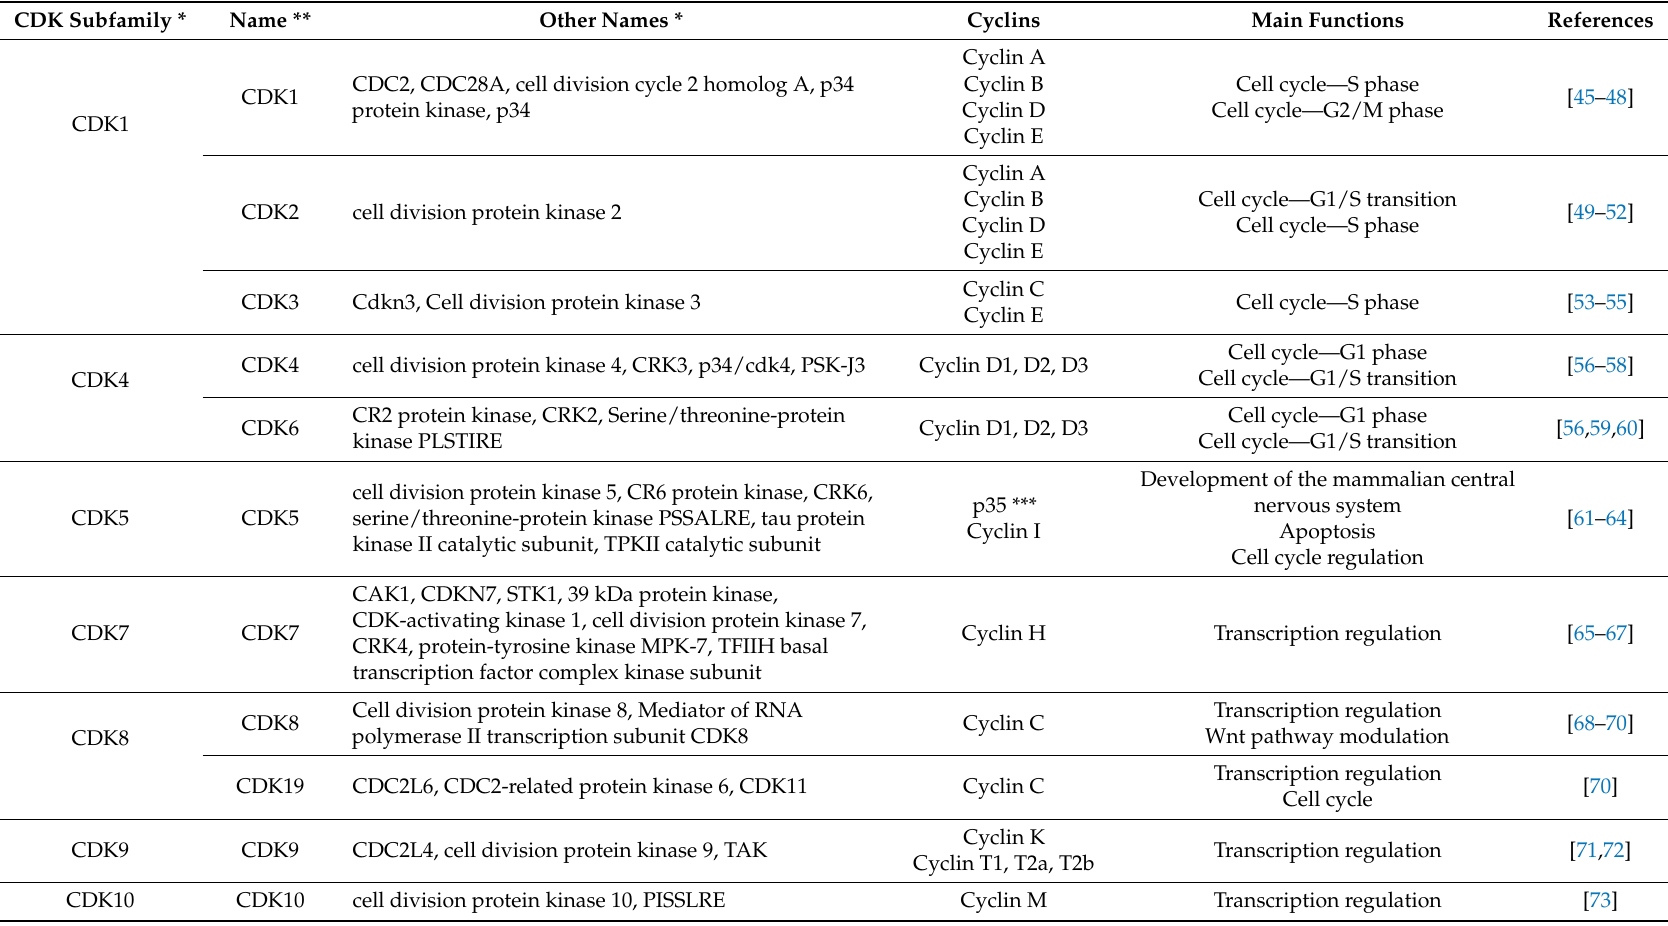
Table 1. Cyclin-Dependent Kinases with corresponding cyclins and their main